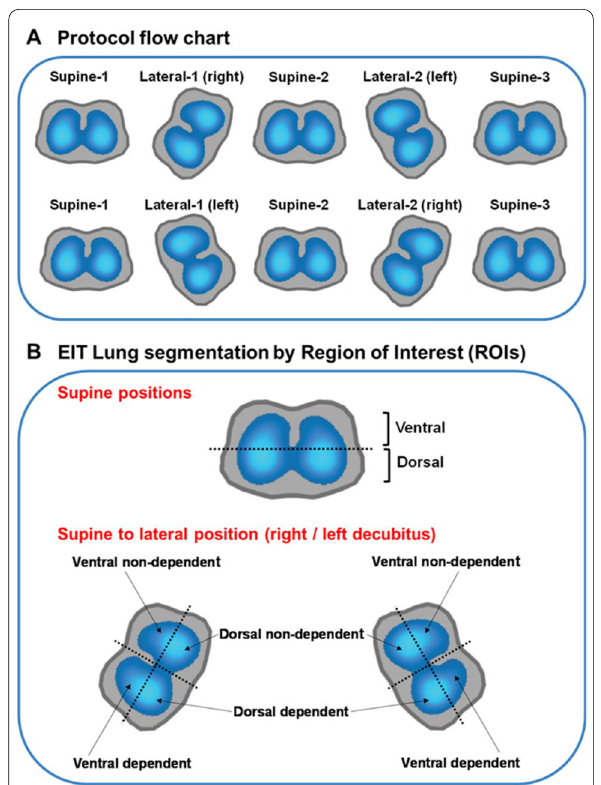
Fig. 1 Protocol flowchart and EIT lung segmentation. The protocol flowchart ( A ) is shown at the top. The positioning sequence begins with the less ventilated lung evaluated by EIT positioned upwards in L1. In section B is shown the EIT lung segmentation by ROIs. To compare changes during supine position, the lungs were segmented into two equally sized ROIs: ventral and dorsal. To compare changes from supine to lateral position, the lungs positioned upwards (non‑dependent) or downwards (dependent lung) during L1 or L2, were segmented into four ROIs or quadrants: ventral non‑dependent, dorsal non‑dependent, dorsal dependent, and ventral